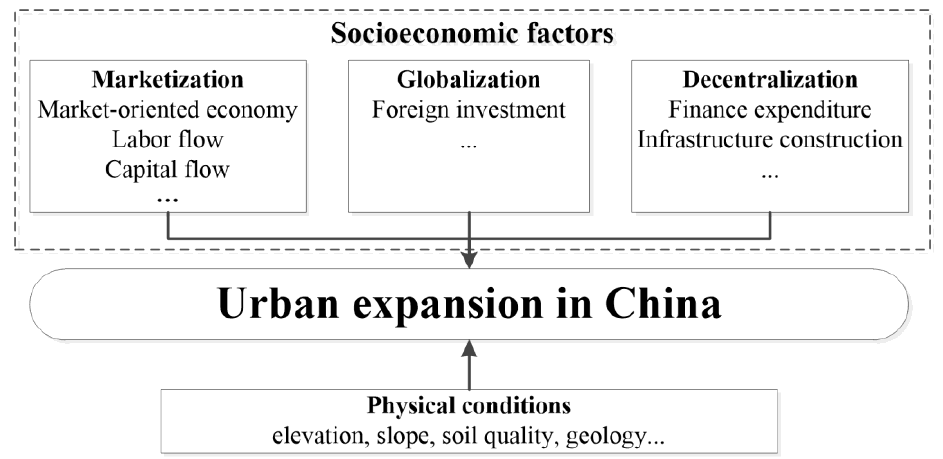
Figure 1. Conceptual framework of the determinants of urban expansion in China.